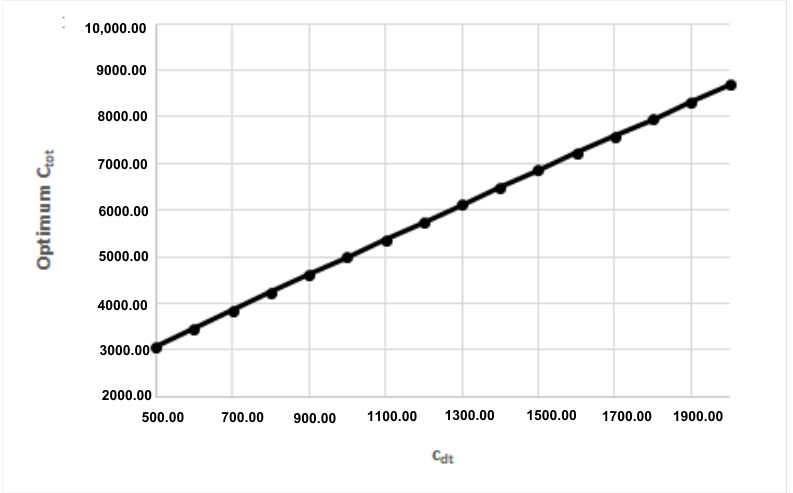
Figure 18. Variations of optimum C tot per c dt .